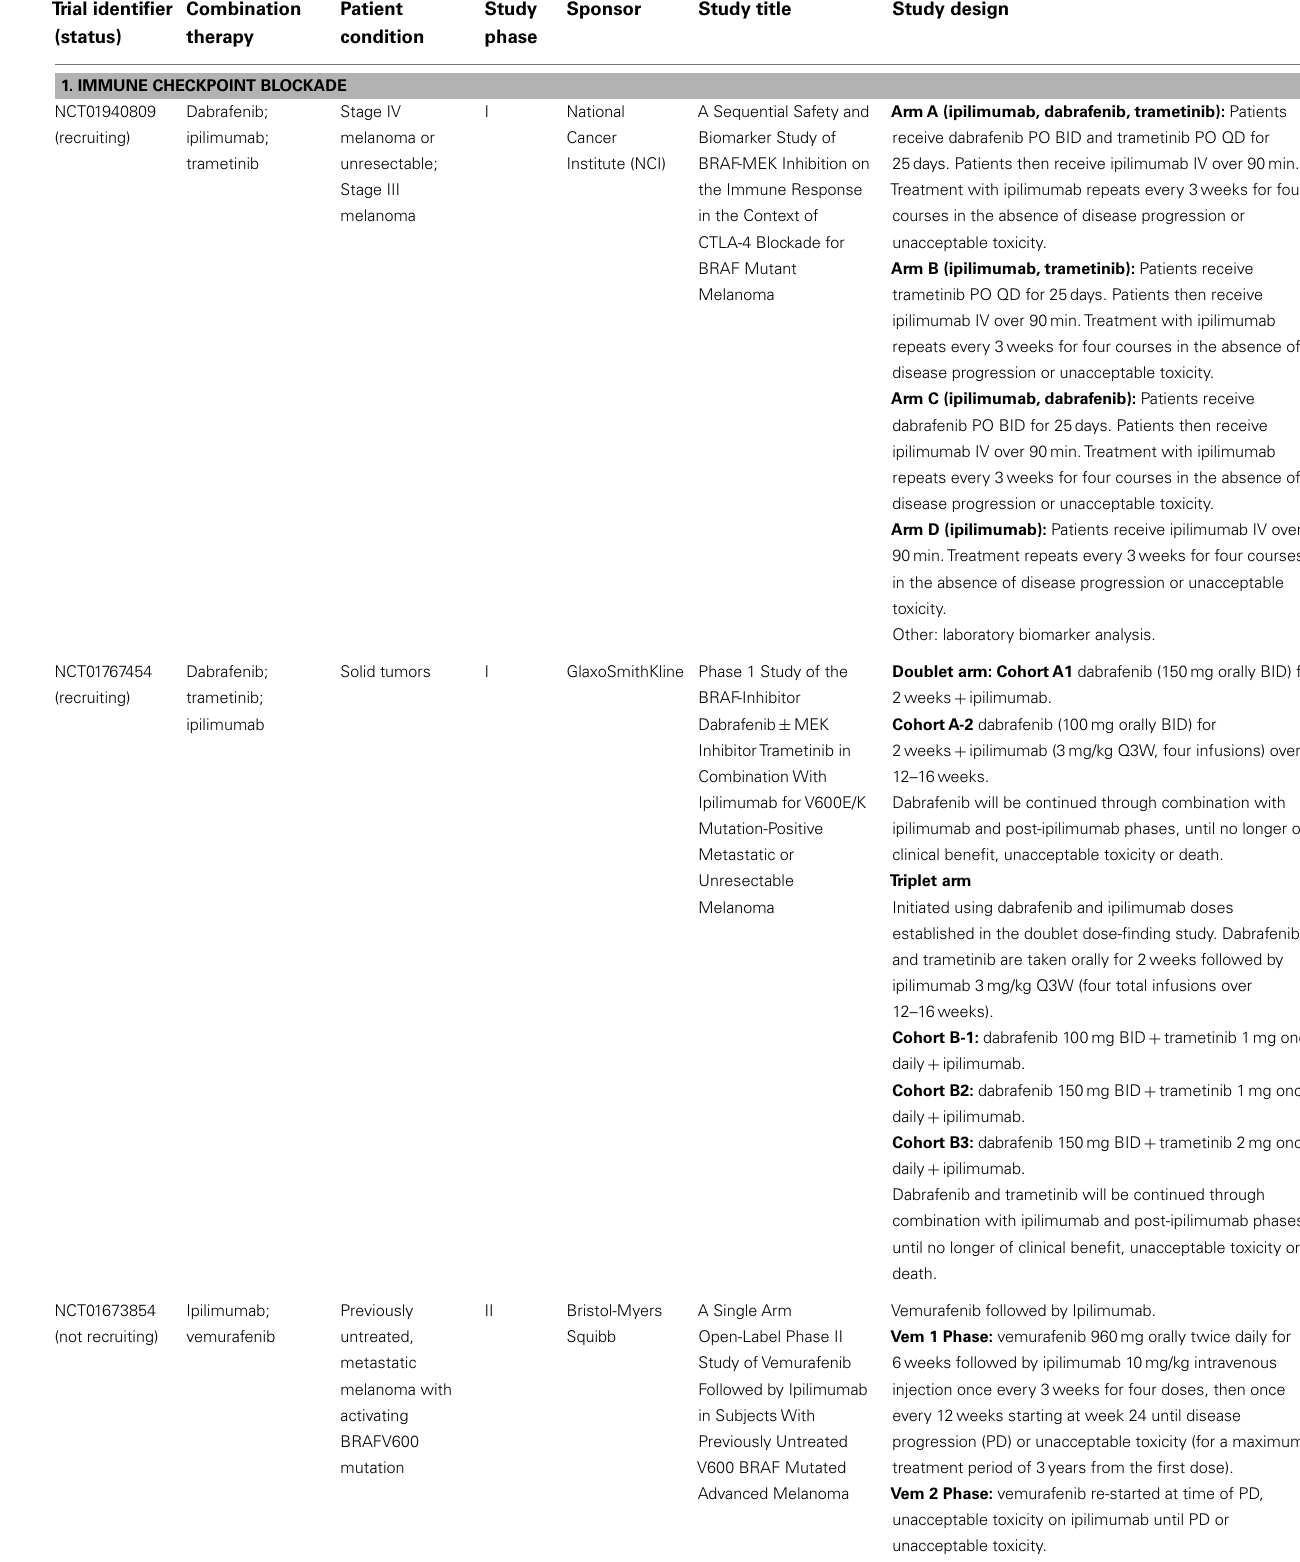
Table 1 | Ongoing clinical studies combining immunotherapy and oncogene-targeted therapy